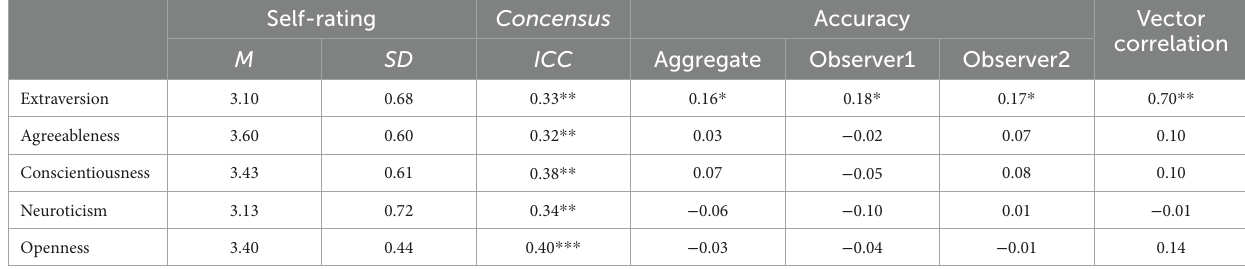
TABLE 1 Self and observer rating of personality: consensus, accuracy, and vector